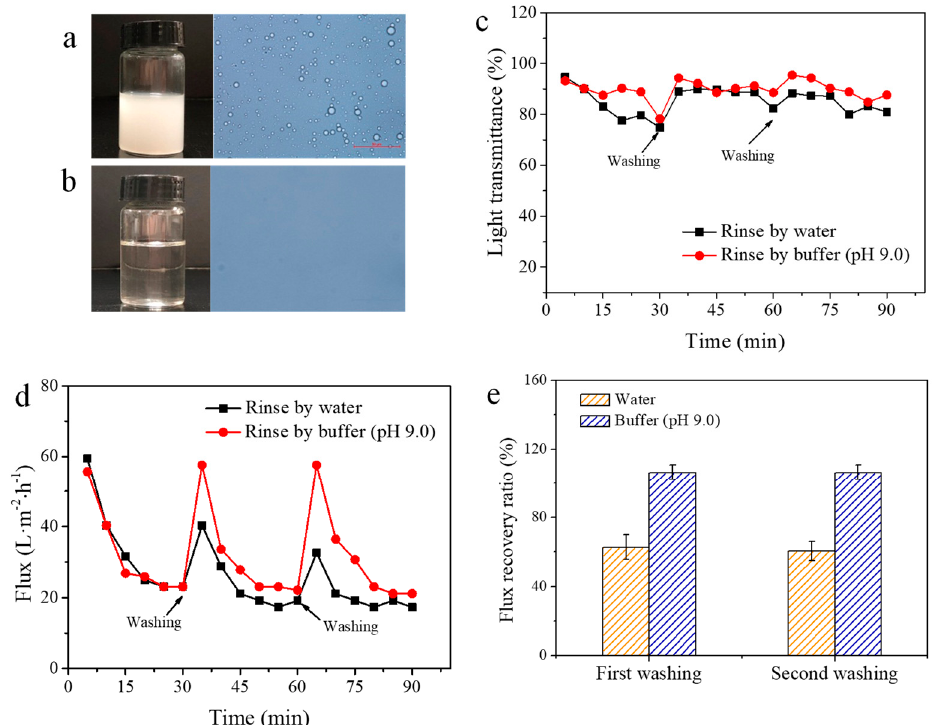
Figure 4. The light transmittance of emulsion ( a ) before and ( b ) after being separated by a PP- g -pDMAEMA membrane; ( c ) the light transmittance and ( d ) the flux of PP- g -pDMAEMA membranes during three cyclic separations; ( e ) FRR in the second and the third cycle.